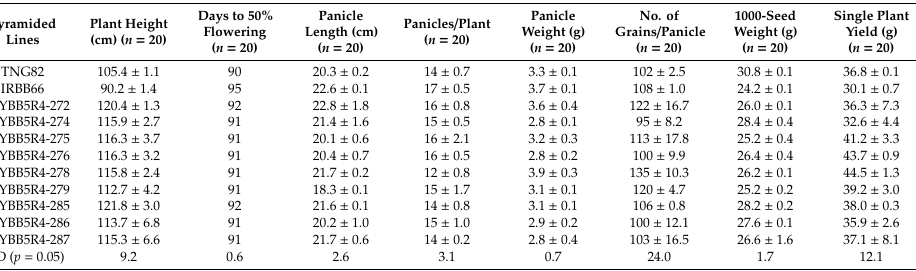
Table 2. Agro-morphologic traits of parental and five-gene-pyramided BC 3 F 4 genotypes. Pyramided